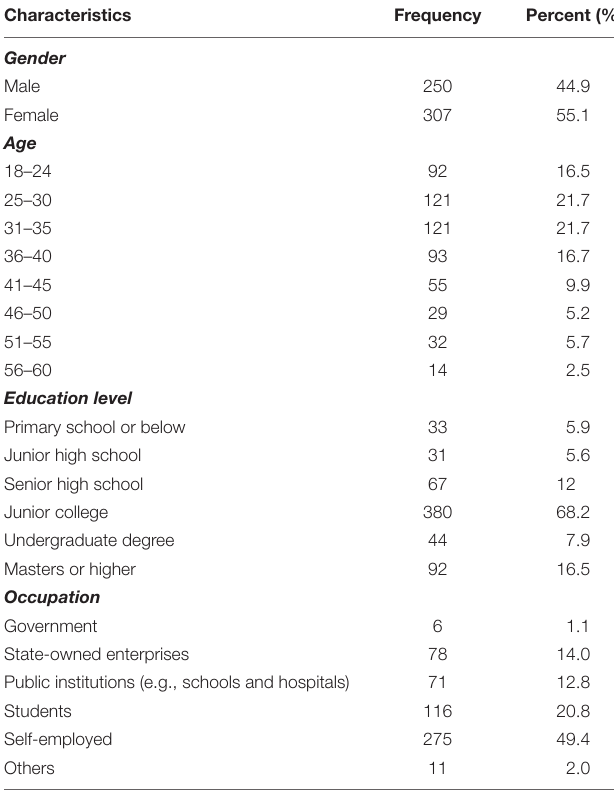
TABLE 1 | Descriptive statistics of demographic